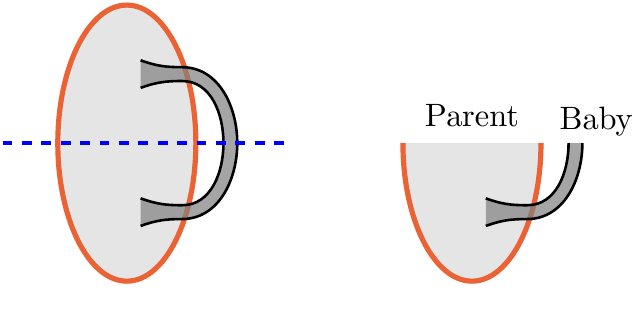
Figure 2 . Slicing open a spacetime with a boundary and a handle (left) can give a disconnected geometry on the slice, including a closed ‘baby universe’ that has become detached from the par- ent asymptotically AdS universe. The baby universe does not intersect the asymptotically AdS boundary (red line) at the moment of time described by the indicated